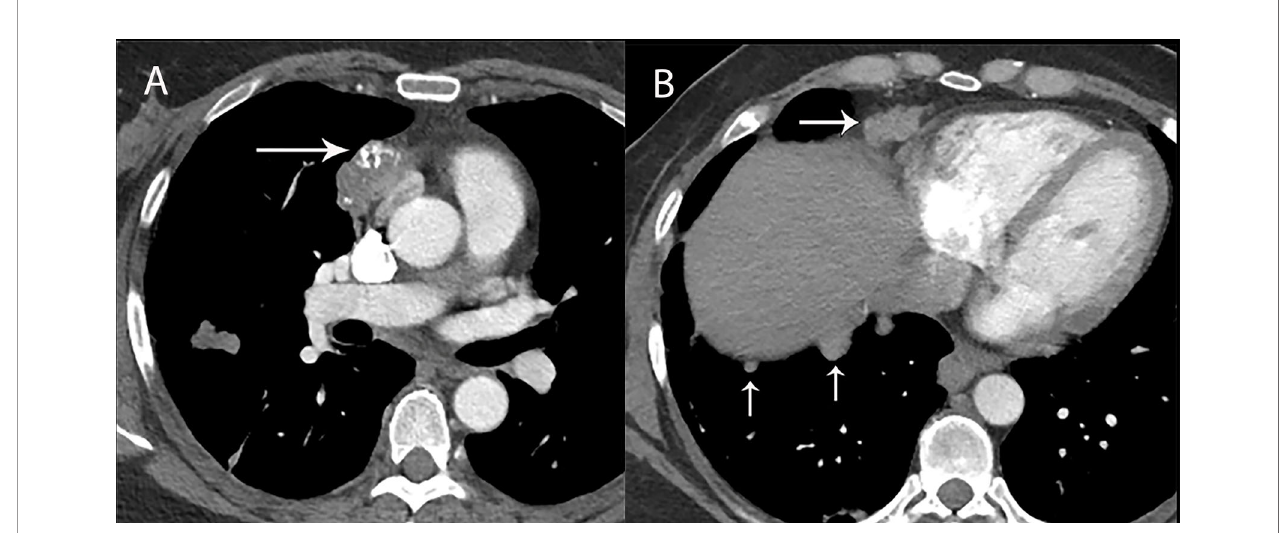
FIGURE 13 | 46 year old woman with thymic carcinoma with pleural metastases. (A) Contrast-enhanced CT shows right prevascular mediastinal mass (arrow) with heterogeneous attenuation and calci fi cations. (B) CT shows nodular right diaphragmatic pleural metastases (vertical arrows) and right anterior diaphragmatic nodal metastasis (horizontal arrow).